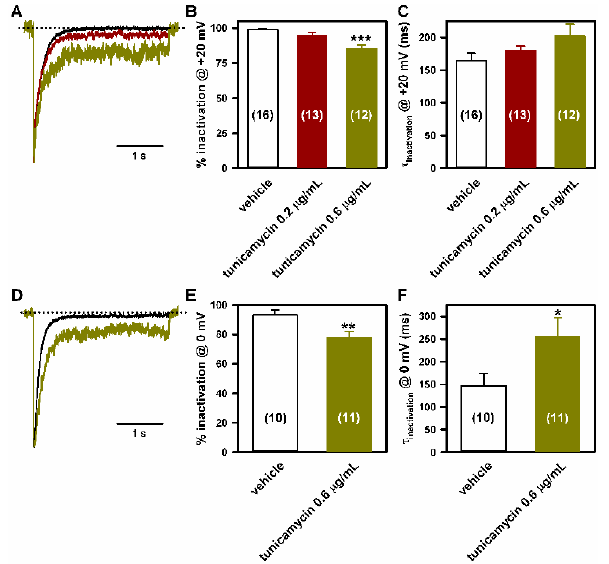
Figure 5. Inactivation of Ca V 2.1 channels heterologously expressed in HEK293 cells is impaired by lowering N -glycosylation. Representative current traces (normalized to the corresponding peak amplitude) illustrating the effects of 0.2 (red trace) and 0.6 μ g/mL (green traces) tunicamycin on Ca V 2.1 inactivation when compared to DMSO-treated cells (black traces), in response to a 3 s depolarizing pulse to +20 mV ( A ) or 0 mV ( D ). The zero current level is indicated by dotted lines. ( B , E ) Average Ca 2+ current inactivation (in %) at the end of these 3 s depolarizing pulses obtained from HEK293 cells expressing Ca V 2.1 channels and treated with DMSO (vehicle) or with tunicamycin (0.2 and 0.6 μ g/mL). Data are expressed as the mean ± SEM of the number of experiments shown in brackets. *** p < 0.001 (Kruskal-Wallis test followed by Dunn post hoc test) and ** p < 0.01 (Student’s t- test) versus the control (vehicle) condition. ( C , F ) Average τ inactivation values of Ca 2+ currents through Ca V 2.1 channels expressed in HEK293 cells treated with DMSO (vehicle) or with tunicamycin (0.2 and 0.6 µ g/mL), elicited by a 3 s depolarizing pulse to +20 mV or 0 mV, as indicated. Data are expressed as the mean ± SEM of the number of experiments shown in brackets. * p < 0.05 versus the control (vehicle) condition (Mann-Whitney U